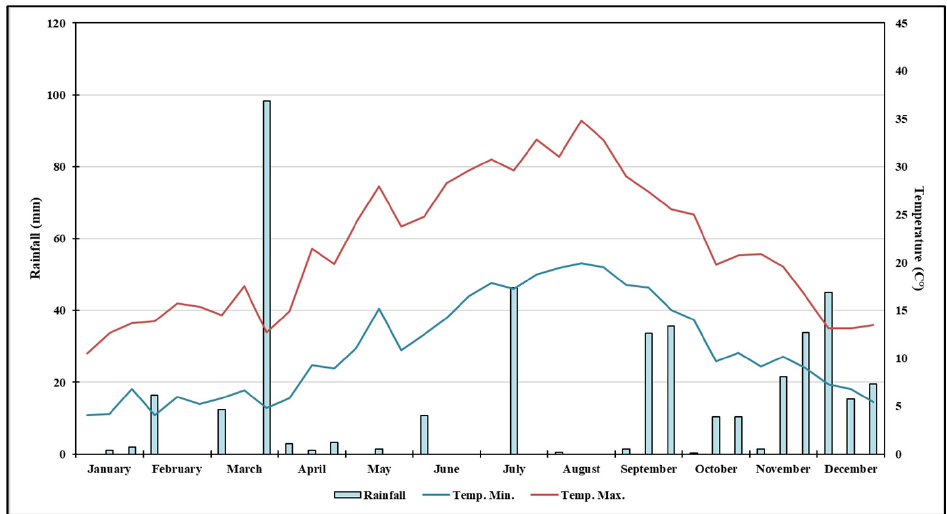
Figure 1. Rainfall and temperature trends in the year 2020. A rainfall of 153 mm, with a more uniform distribution, was observed during the same period in 2021 (Figure 2).